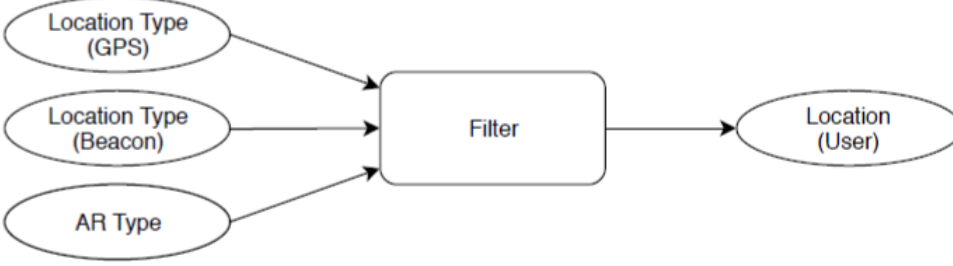
Figure 7. Overview: Kalman filter data flow.